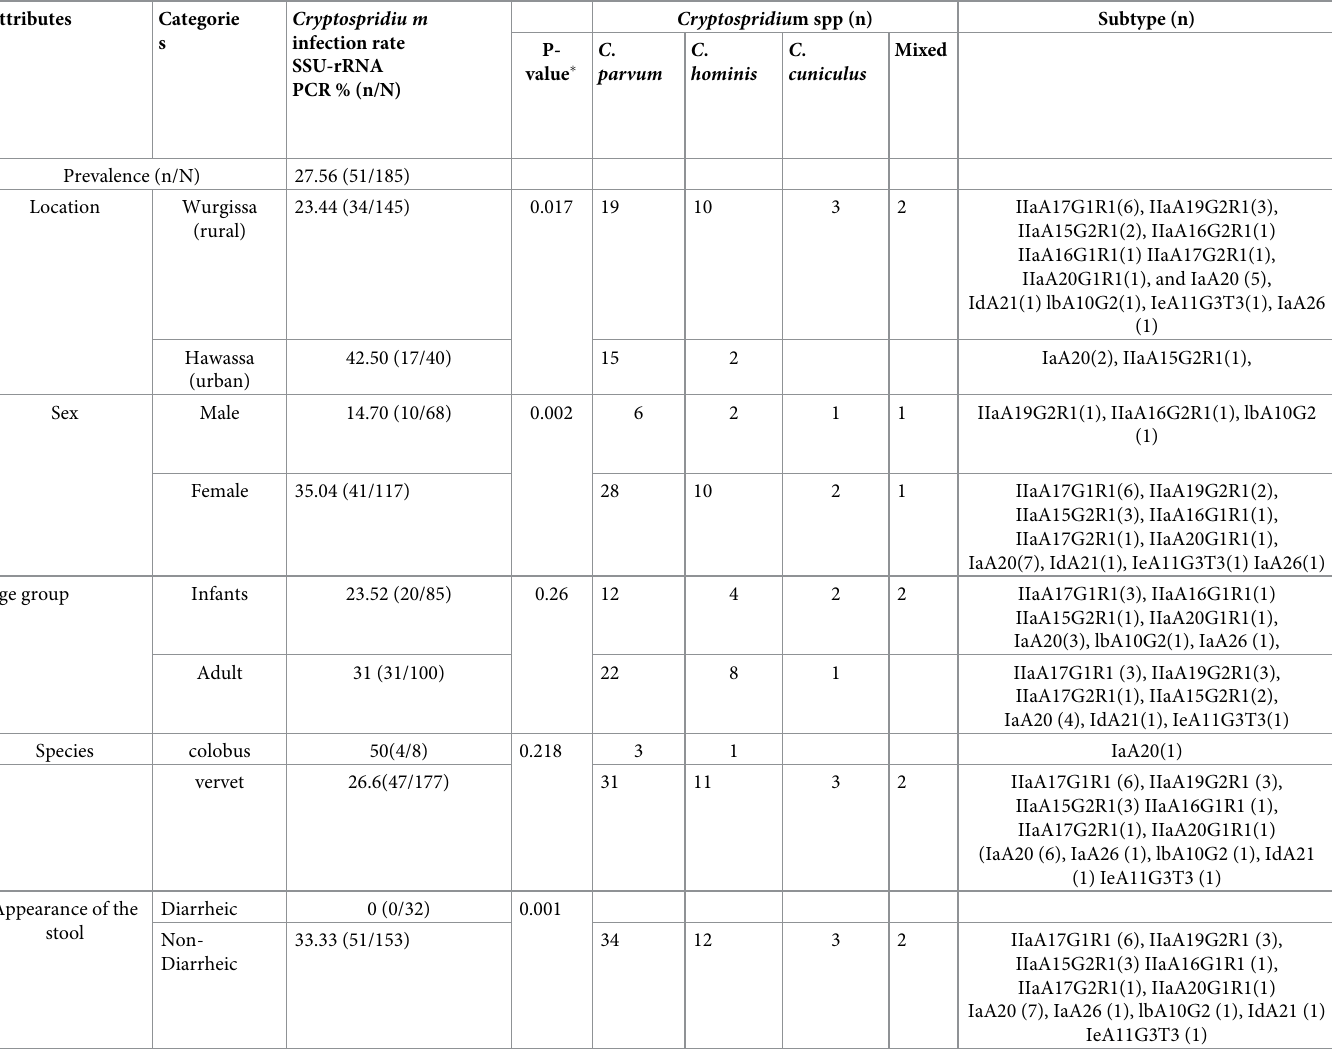
Table 2. Prevalence of Cryptosporidium infection by age, sex, and stool character among